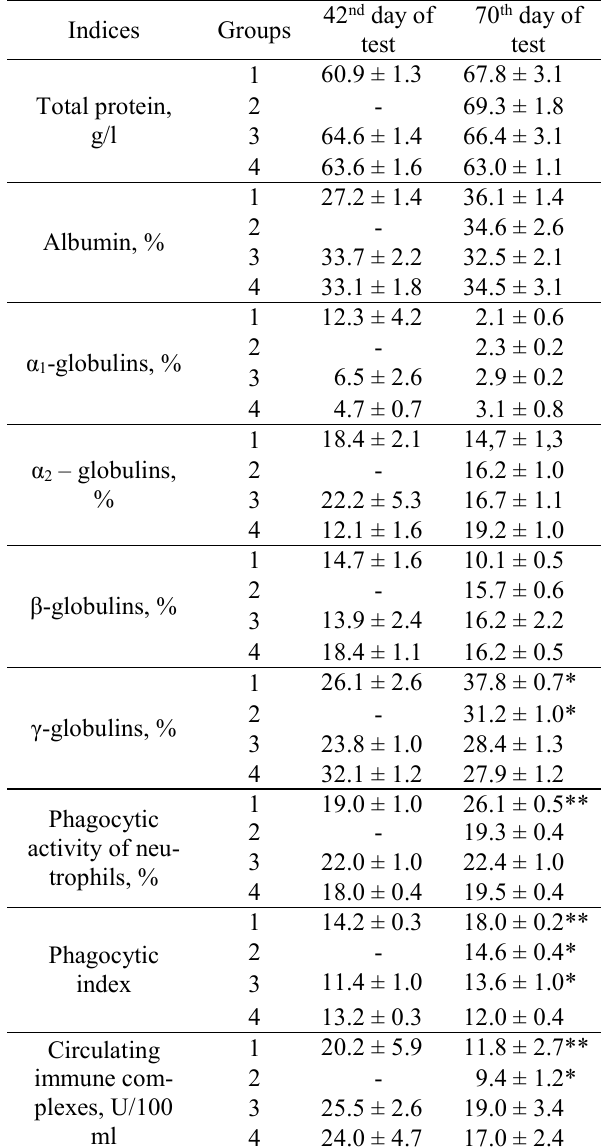
Indices of immunophisiological state of piglets at